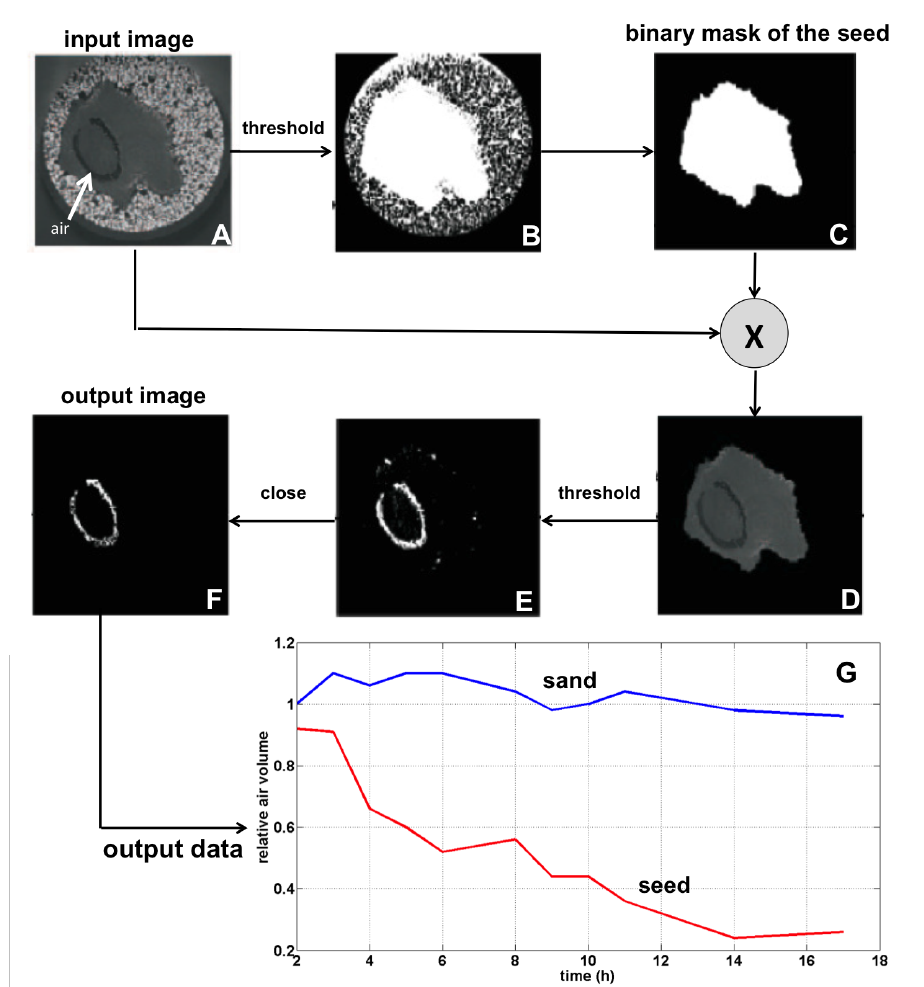
Figure 1. Main steps of the image processing pipeline for the extraction of the volume of air